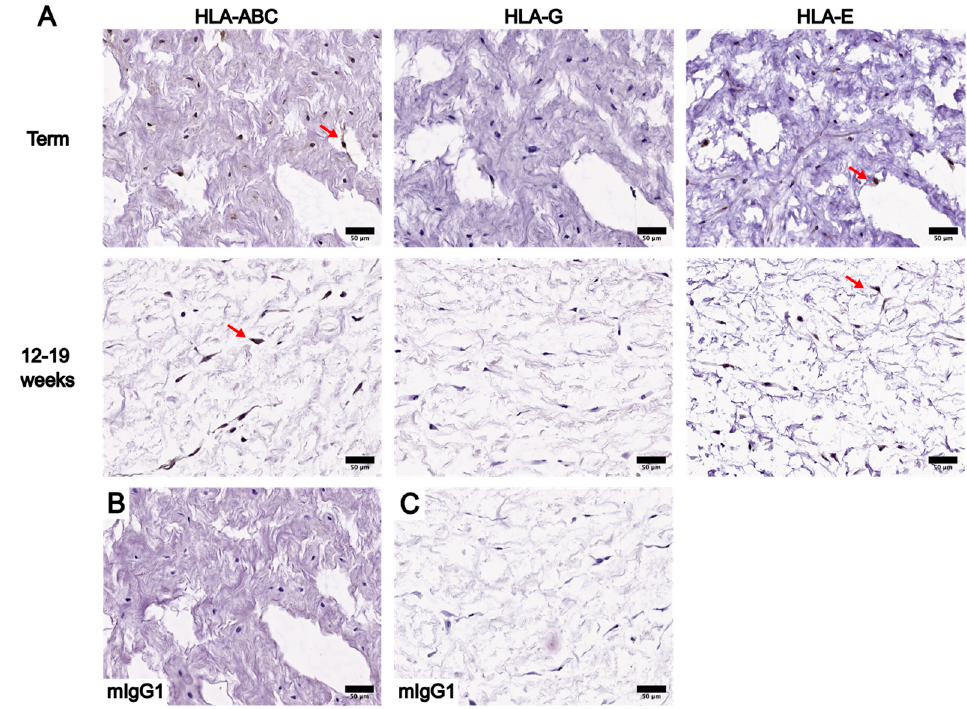
Figure 4. Comparison of IHC staining results of HLA-ABC, HLA-G, and HLA-E in whole UC cross- sections at term and in 12–19 weeks, focusing on the IWJ. ( A ) IHC staining results of term UC are shown in the first row, and IHC staining results of UC between 12 and 19 weeks are shown in the second row. Red arrows: examples of cells in the IWJ showing positive staining for the corresponding HLA of interest. ( B ) Negative control of term UC IHC staining results using an anti-mIgG1 antibody. ( C ) Negative control of 12–19-week UC IHC staining results using an anti-mIgG1 antibody. Scale bars = 50 µm.